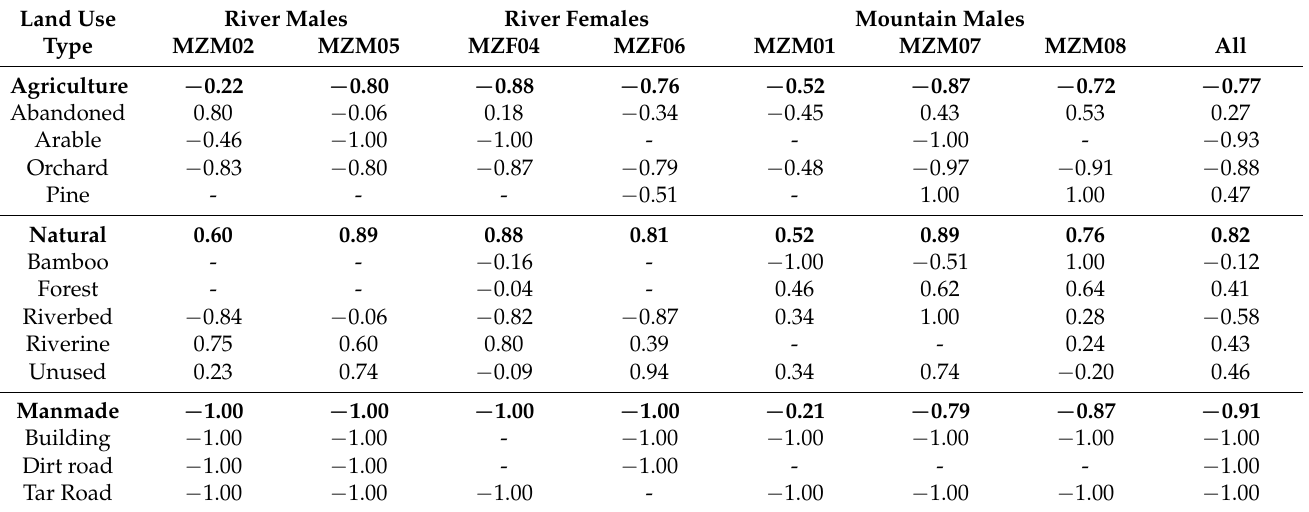
Table 4. Jacobs’ index for land use classes (in bold) and subclasses at leopard cat daytime resting sites: land use types are selected (>0.2), avoided (< − 0.2), or used according to availability ( − 0.2–0.2), only land use types with a total sample size for resting sites and/or random points of >5 were included.